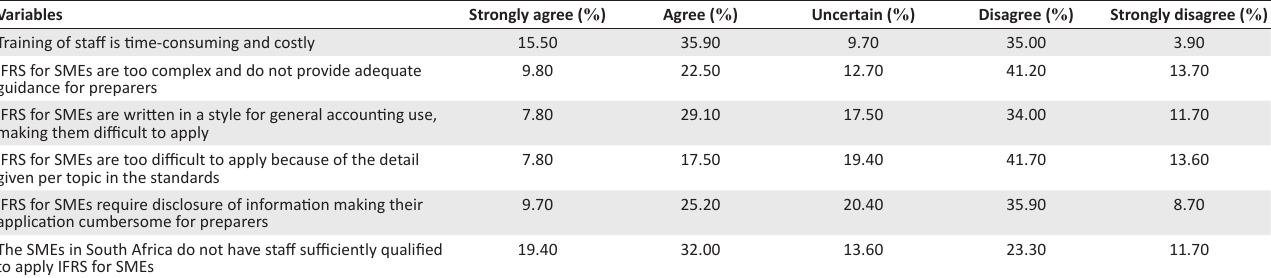
TABLE 4: Extent to which practitioners agreed with the challenges of using the International Financial Reporting Standards for small and medium-sized entities. Variables